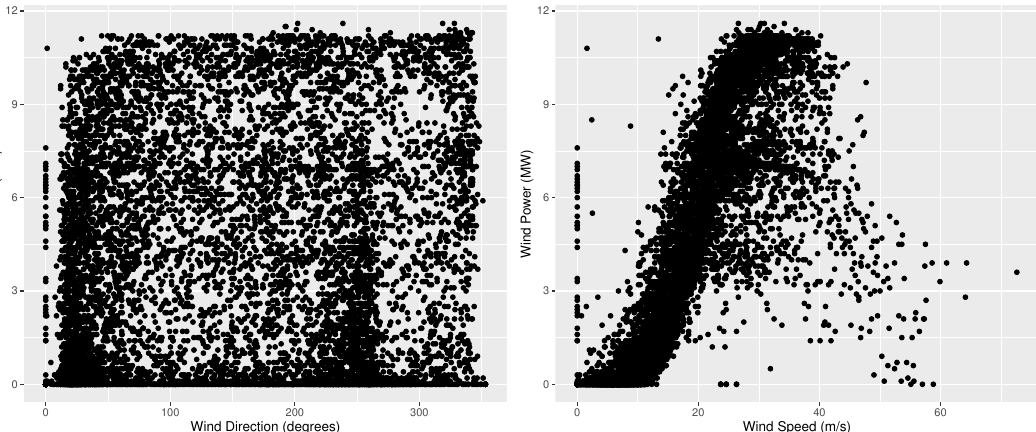
Figure 1. Wind power (measured in MV) compared with wind direction (degrees) and speed (m/s) for the Aeolos farm. The panels represent the empirical power curves of the farm, being subject to wind direction ( left ) and speed ( right ),